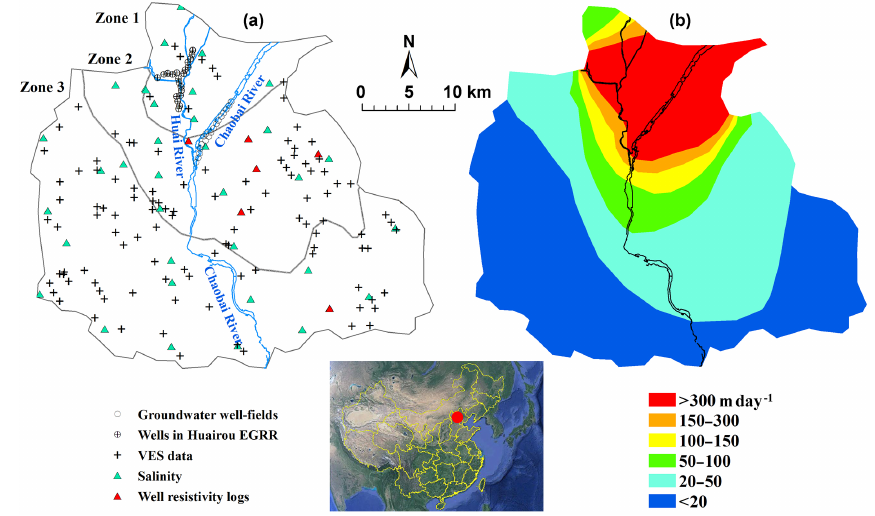
Figure 1. Chaobai alluvial fan in the north of Beijing Plain. (a) Location of the study area and distribution of the field data. (b) Map of the hydraulic conductivity issued by Beijing Institute of Hydrogeology and Engineering Geology (2007). The location of the study area is shown in the inset.